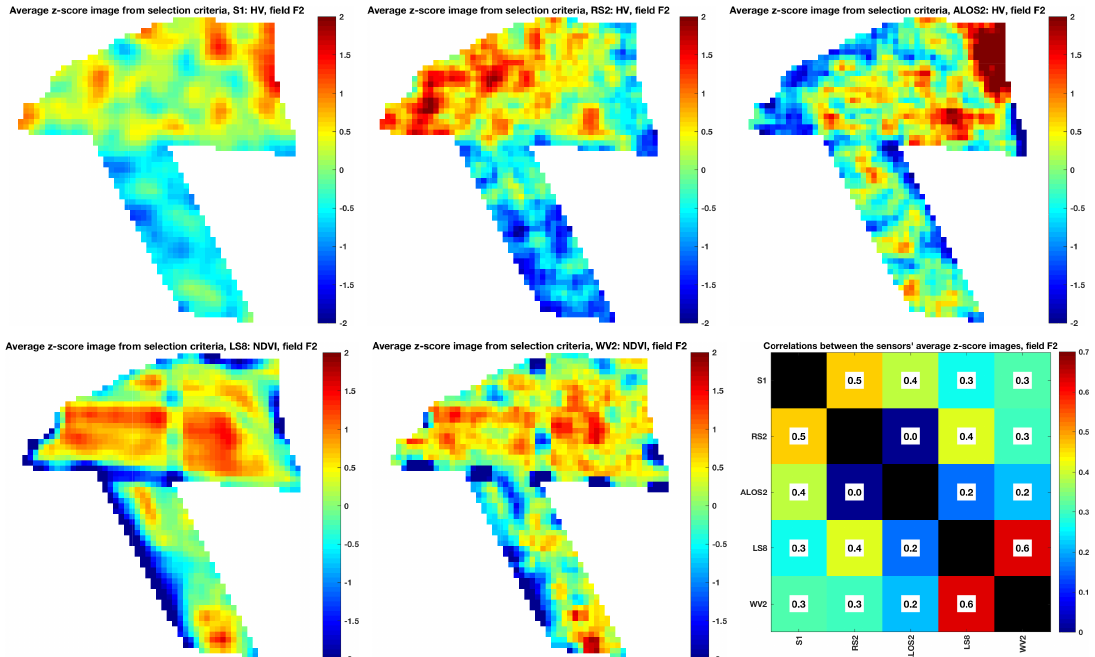
Figure 17. Field F2 average z-scores from images specified by the selection criteria for the different sensors (field plots), and corresponding correlations of these images between the different sensors (bottom right). Correlation coefficients are displayed in each cell, and diagonal values were omitted and colored